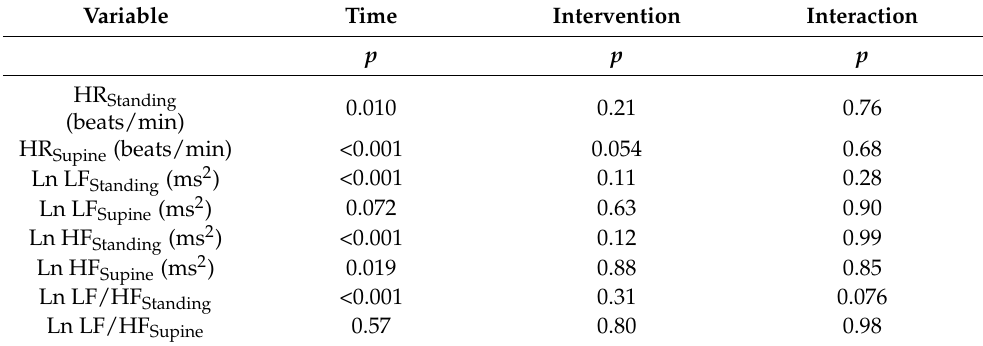
Table 1. Influence of low-frequency sound on heart rate variability indices in pre/post-test measures. Variable Time Intervention Interaction p p p HR Standing 0.010 0.21 0.76 (beats/min) HR Supine (beats/min) <0.001 0.054